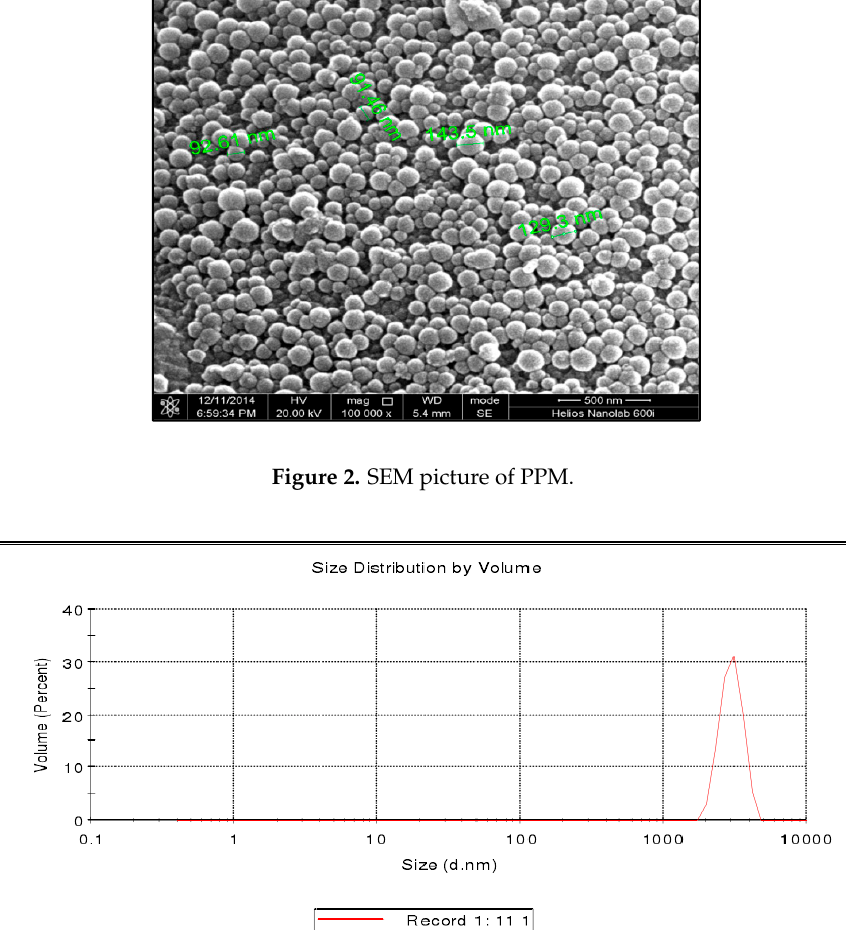
Figure 1. Emulsification cross-linking schematic.